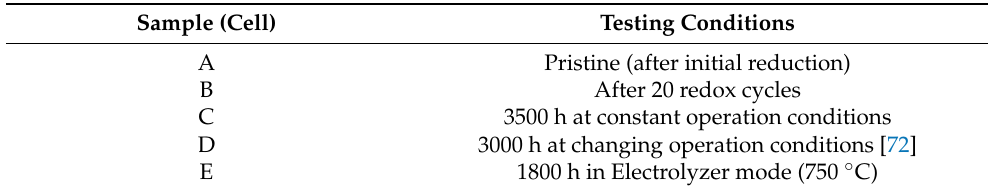
Table 4. Samples